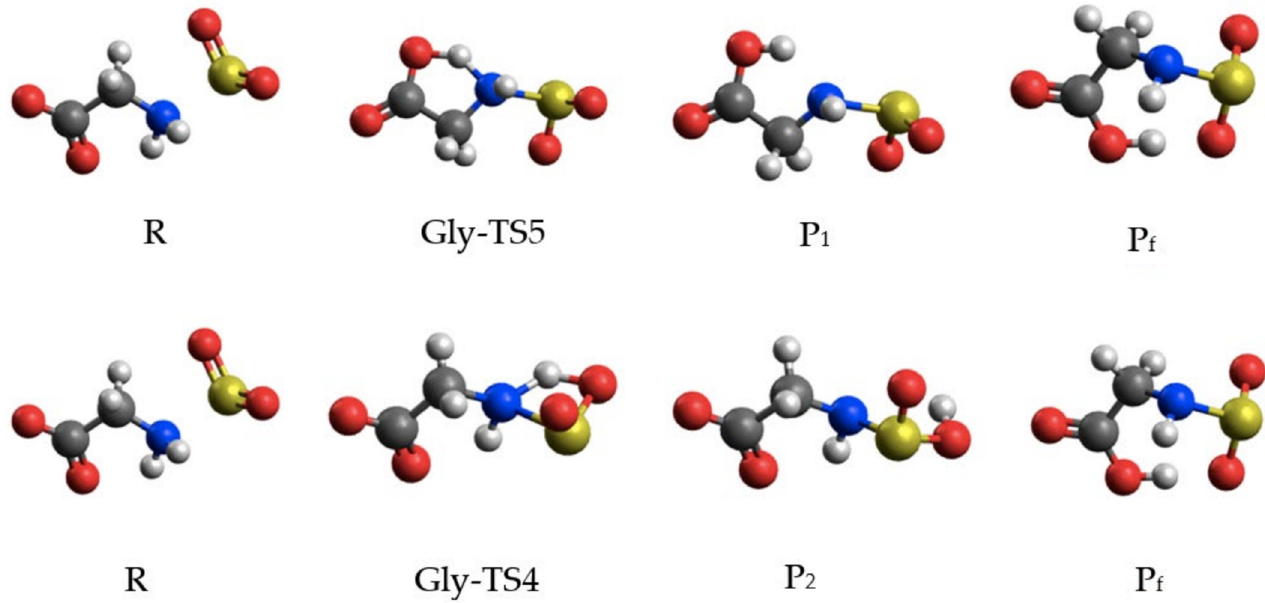
Figure 1. Stationary point geometries along the reaction of [Gly] − with SO 2 . ( Top ): Path with a 5-mamber transition state that sees the transfer of a proton toward the carboxylate. ( Bottom ): Path involving a 4-member ring with proton transfer on the SO 2 . The last two structures in the top sequence are conformers, while those of the bottom sequence are isomers.